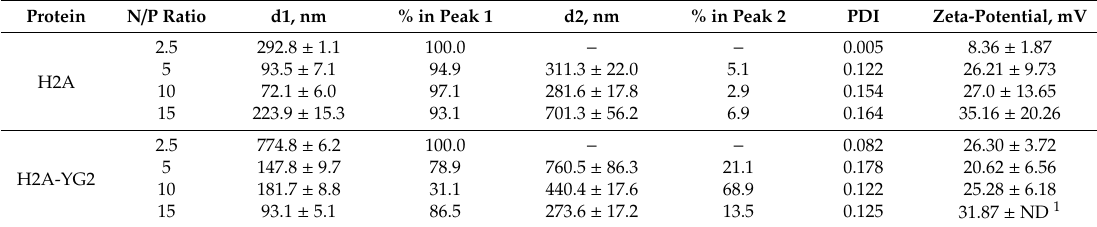
Table 2. Physicochemical parameters of the histone:pDNA complexes. Mean hydrodynamic diameter of particles in the observed peaks (d1 and d2), % of particles in the peaks, polydispersity index (PDI), and zeta-potential of the complexes at di ff erent N / P charge ratios (2.5, 5, 10, 15) are shown. Mean values are shown; where applicable, the result is shown as mean ± standard